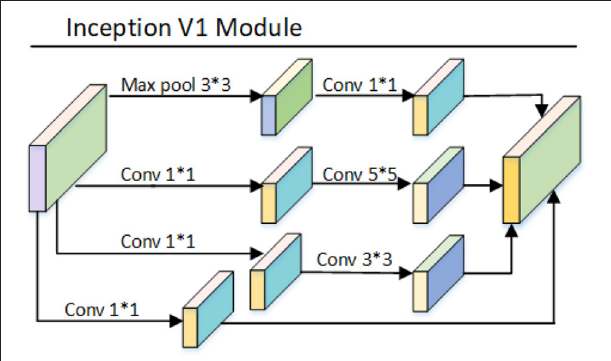
FIGURE 5 | Inception V1 model structure